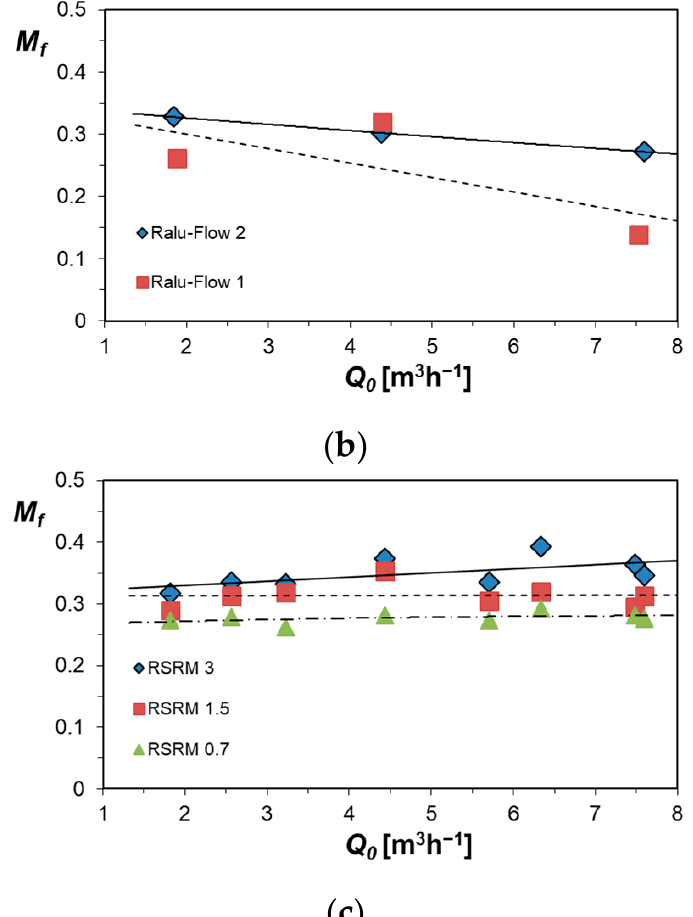
Figure 8. Maldistribution factor as a function of the total liquid flow rate of: ( a ) Plastic Raschig Super–Ring; ( b ) Ralu–Flow; ( c ) Reference: Metal Raschig Super–Ring [41] (with the permission of Chem. Eng. Trans.).